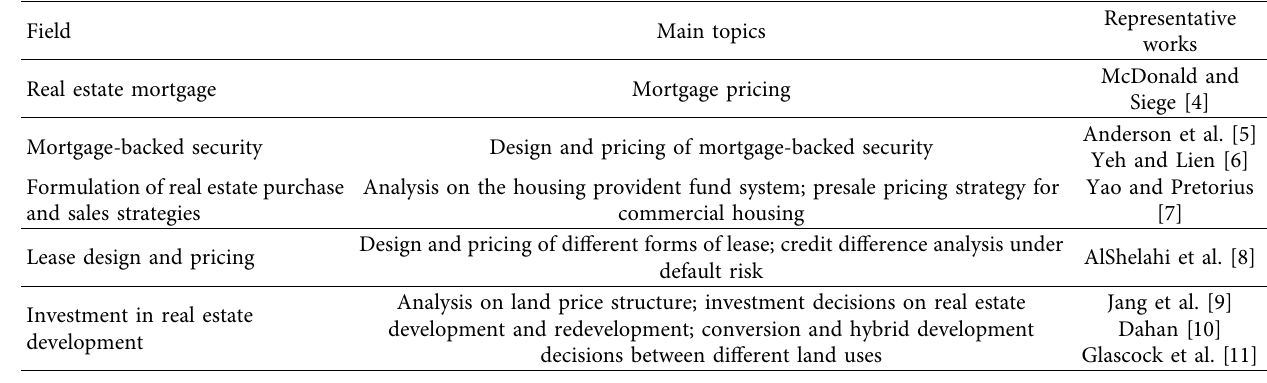
Table 1: Representative foreign studies of real estate based on real option